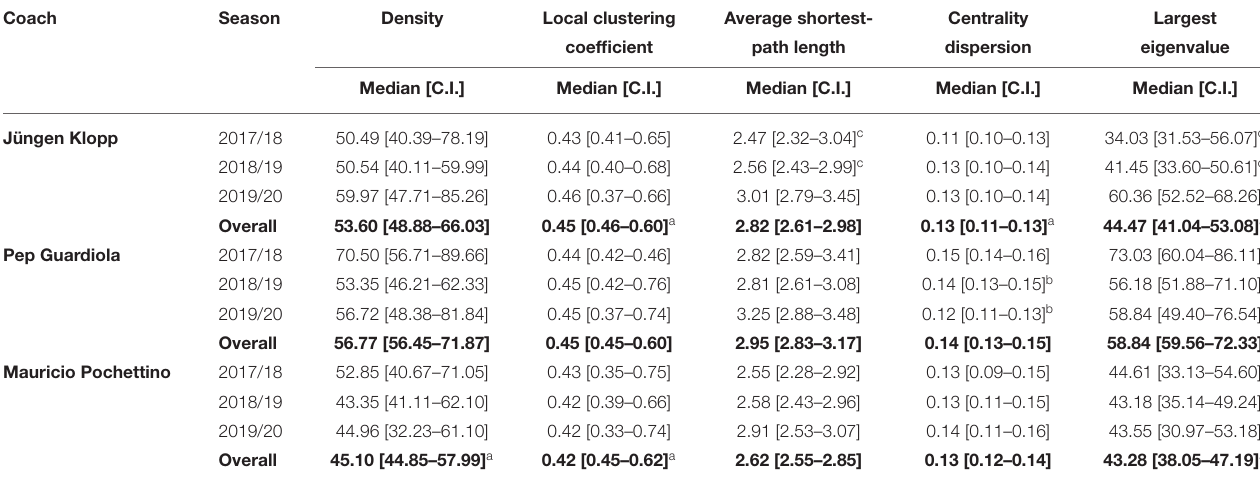
TABLE 1 | Passing network metrics descriptive of Klopp’s, Guardiola’s and Pochettino respective teams (Liverpool FC, Manchester City FC, and Tottenham Hotspur FC along 3 UEFA Champions League seasons). Coach